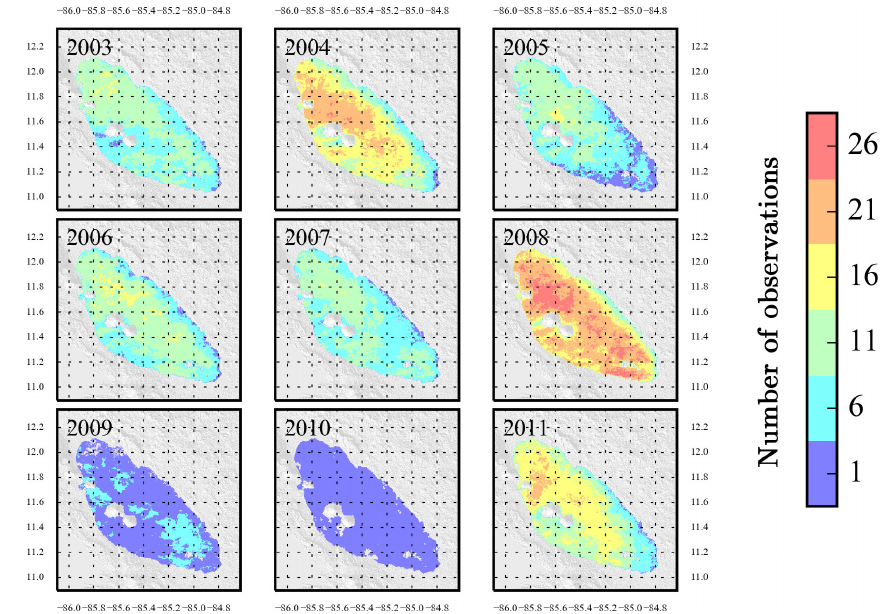
Figure 16. Number of observations for the annual cyanobacteria abundance maps in Fig. 15 ( num_obs